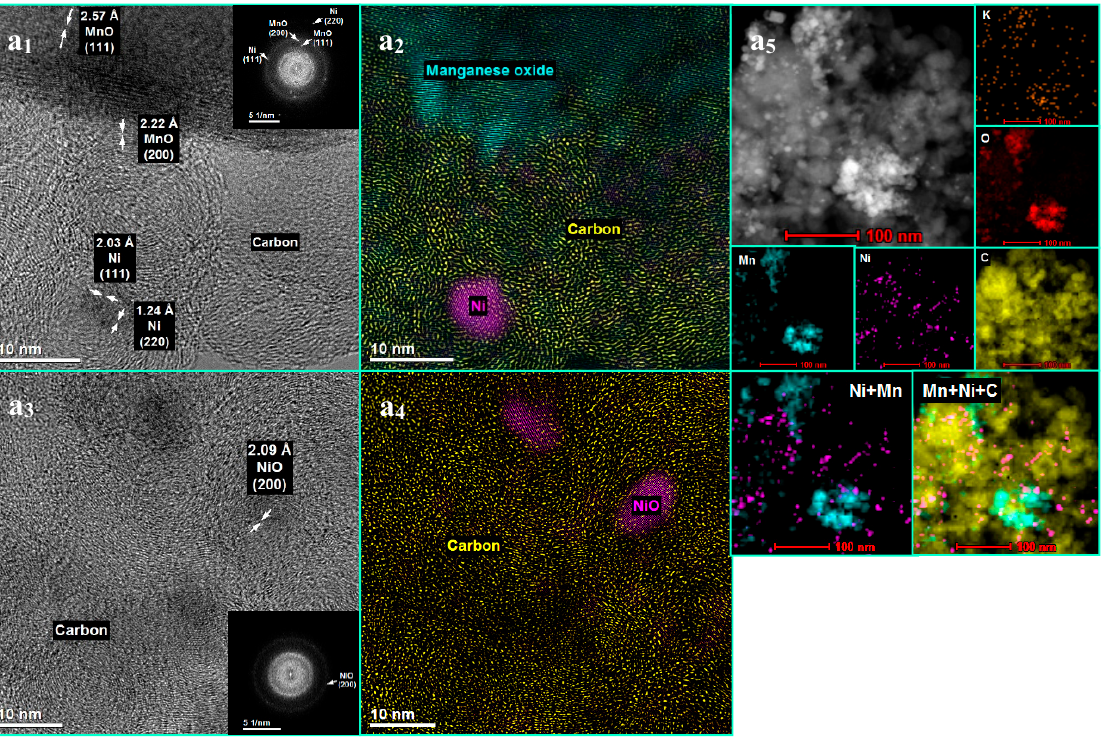
Figure 9. Microscopic analysis of the Ni/MnO x catalyst after 18 h of SRE reaction at 420 °C